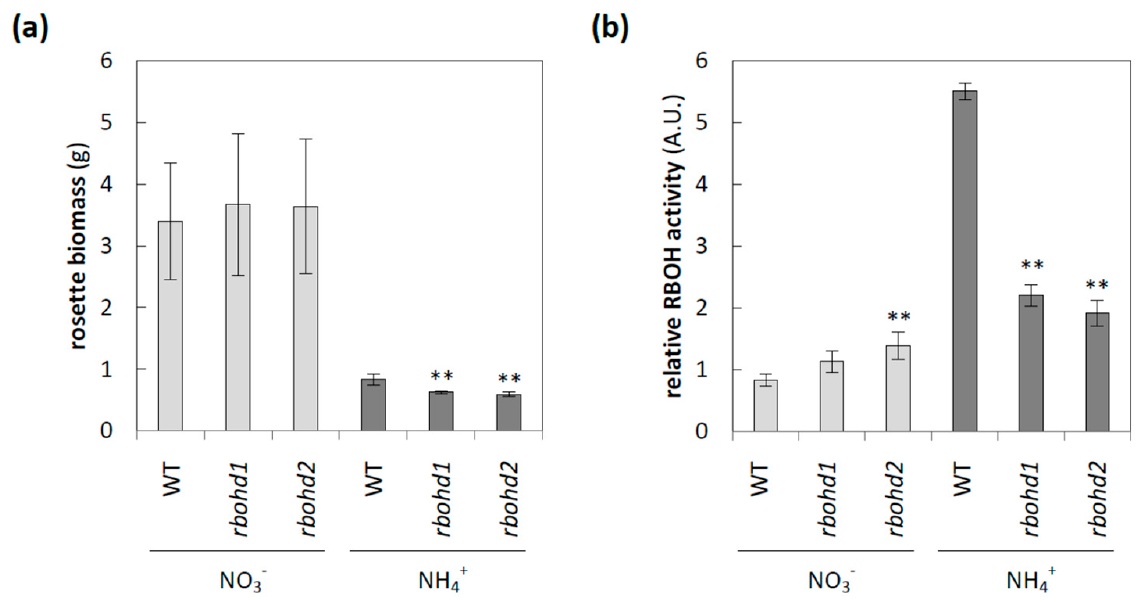
Figure 1. Phenotypic characterization of rbohd plants. ( a ) Rosette biomass of 8-week-old WT and rbohd plants grown in nitrate or ammonium as the sole nitrogen source. ( b ) Relative activity of RBOH measured as DPI-sensitive superoxide production. Comparison tests between rbohd and WT plants were performed on the mean of experimental conditions for the nitrate (light grey) or ammonium (dark grey) growth regime separately. Statistical differences calculated using one-way analysis of variance (ANOVA) with Tukey’s post hoc test are indicated at p -value ≤ 0.01 **.